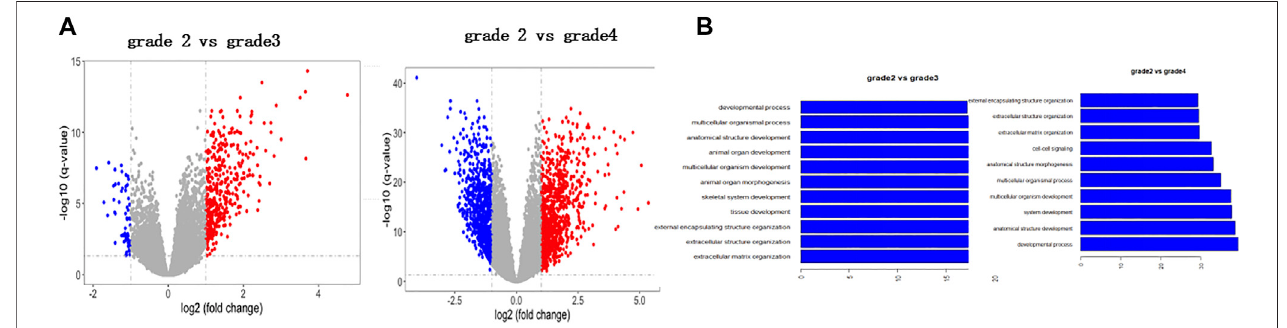
FIGURE1| Identi fi cation ofnewdifferentially expressed genesinglioma tissuesaccordingtothebioinformatic analysis. (A) Volcanoplot indicating changed genes in grade 2 glioma compared to grade 3 glioma. Red and blue dots indicate grade 3 glioma genes, respectively ( p < 0.05, fold change > 2). (B) Volcano plot showing genetic changes in grade 2 gliomas, but not in grade 4 gliomas. Red and blue dots represent four-level glioma genes, respectively ( p < 0.05, fold change > 2).